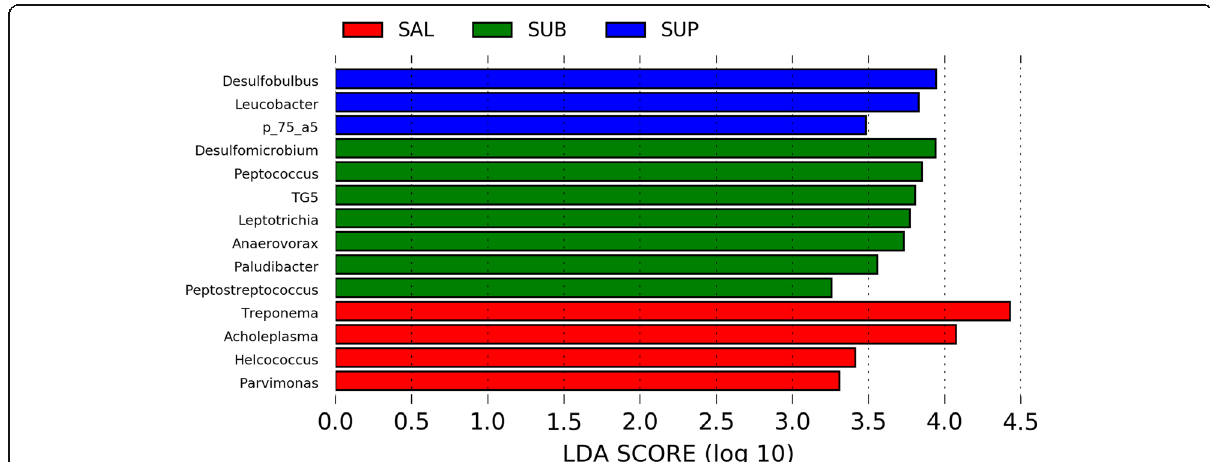
Fig. 6 LEfSe results of oral samples identified bacterial genera enriched in salivary (SAL), subgingival (SUB) plaque, and supragingival (SUP) plaque of healthy adult dogs. LDA score ≥ 3